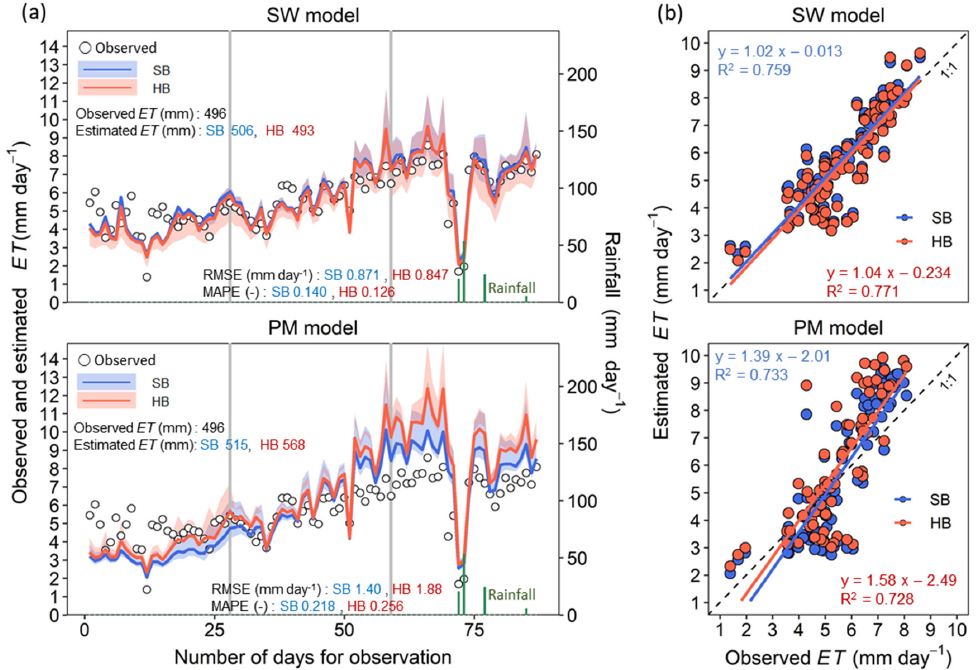
Figure 8. ( a ) Comparison of observed evapotranspiration ( ET ) for the paddy rice field in the dry season of 2017 (PrD2) and estimated ET produced by the Shuttleworth–Wallace (SW) and the Penman–Monteith (PM) models with calibrated parameters using the simple Bayesian (SB) and hierarchical Bayesian (HB) approaches for the paddy rice field in the dry season of 2019 (PrD1). Lines and bands indicate the mean values and 95% confidence intervals of the estimated ET . ( b ) Regression analysis of estimated ET calculated by the SW and the PM models using calibrated parameters of PrD1 with observed ET of PrD1. RMSE, root mean square error; MAPE, mean absolute percentage error; R 2 , coefficient of determi- nation.